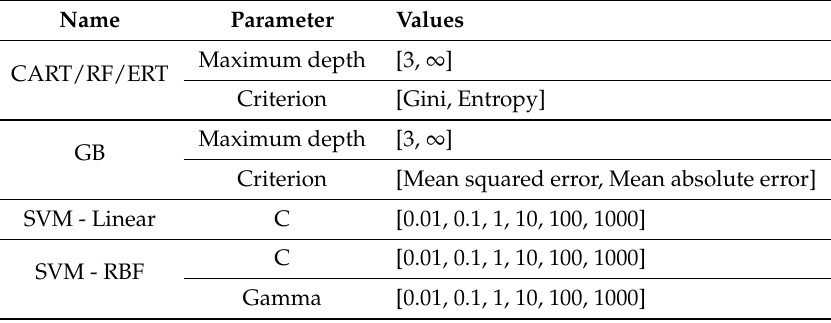
Table 3. List of all of the classification models performed in this study and their referring evaluated